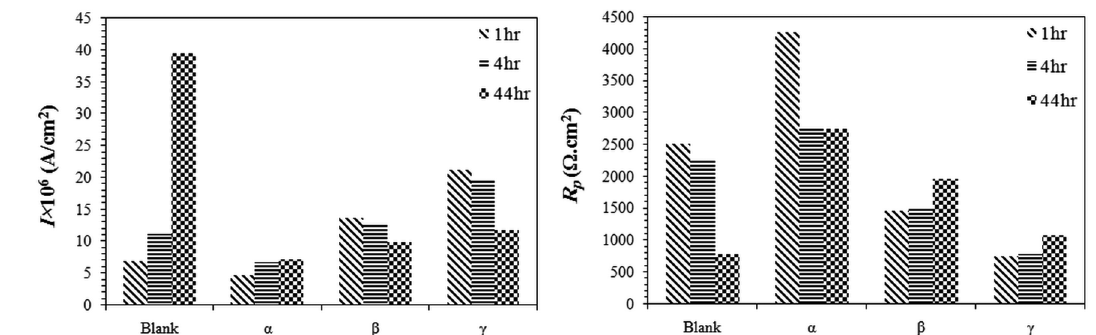
Figure 5. The corrosion current density (left) and polarization resistance (right) of the samples immersed in the test solutions.